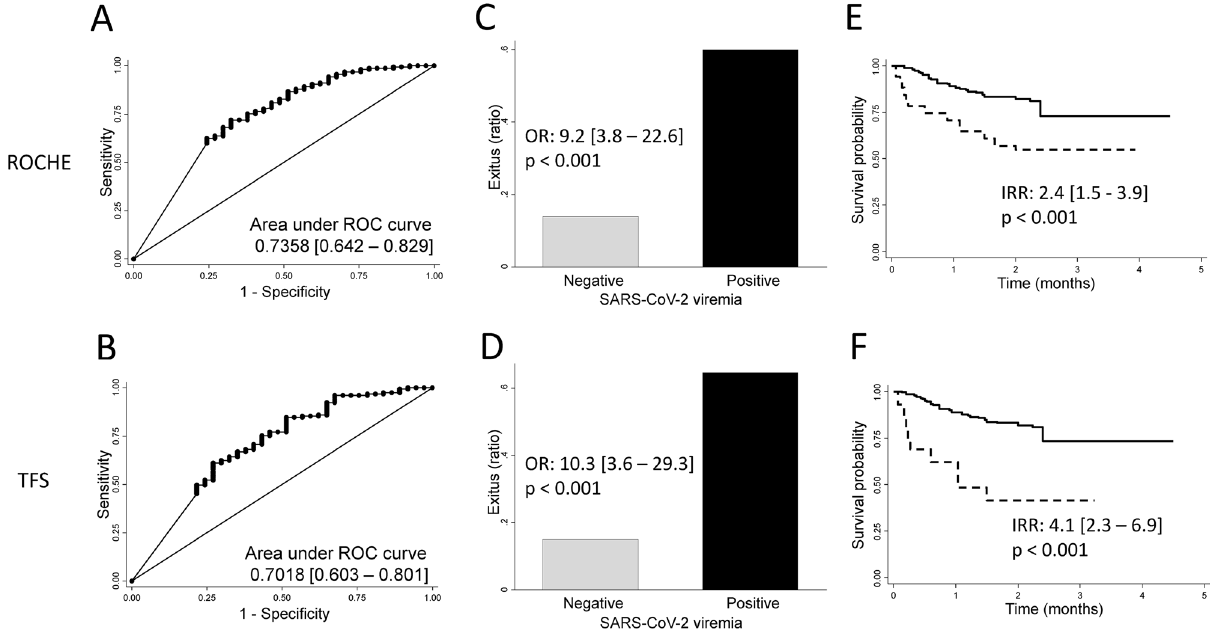
Figure 2. Comprehensive analysis of viremia as a prognostic marker of mortality in patients hospitalized for severe COVID-19. ROC curve-analysis for mortality prediction with Ct values in serum of all patients, according to Roche ( A ) and Thermo Fisher Scientific [TFS] ( B ) techniques. Proportion of deceased patients according to the presence (positive) of absence (negative) of relevant viremia determined by Roche ( C ) and TFS ( D ) techniques. Survival analysis with Kaplan–Meier estimator of patients hospitalized for COVID-19 who presented (dotted lines) and patients who did not present (solid lines) relevant viremia according to Roche ( E ) and TFS ( F )